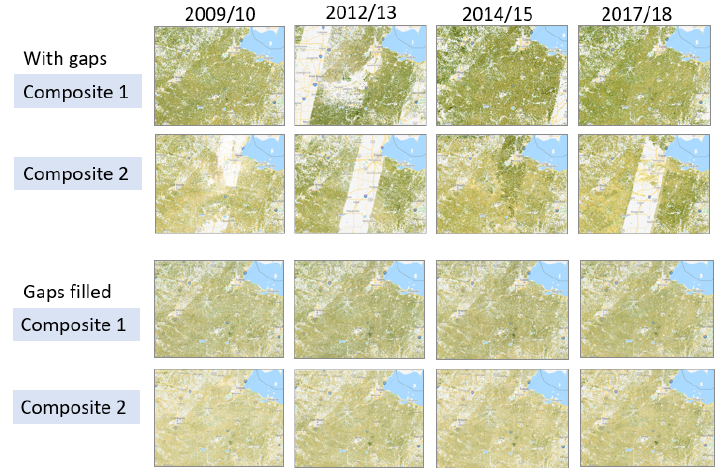
Figure 4. Landsat satellite image composites before and after gap filling. Composite 1 represents fall growth (from October to December) and Composite 2 represents spring growth (from January to